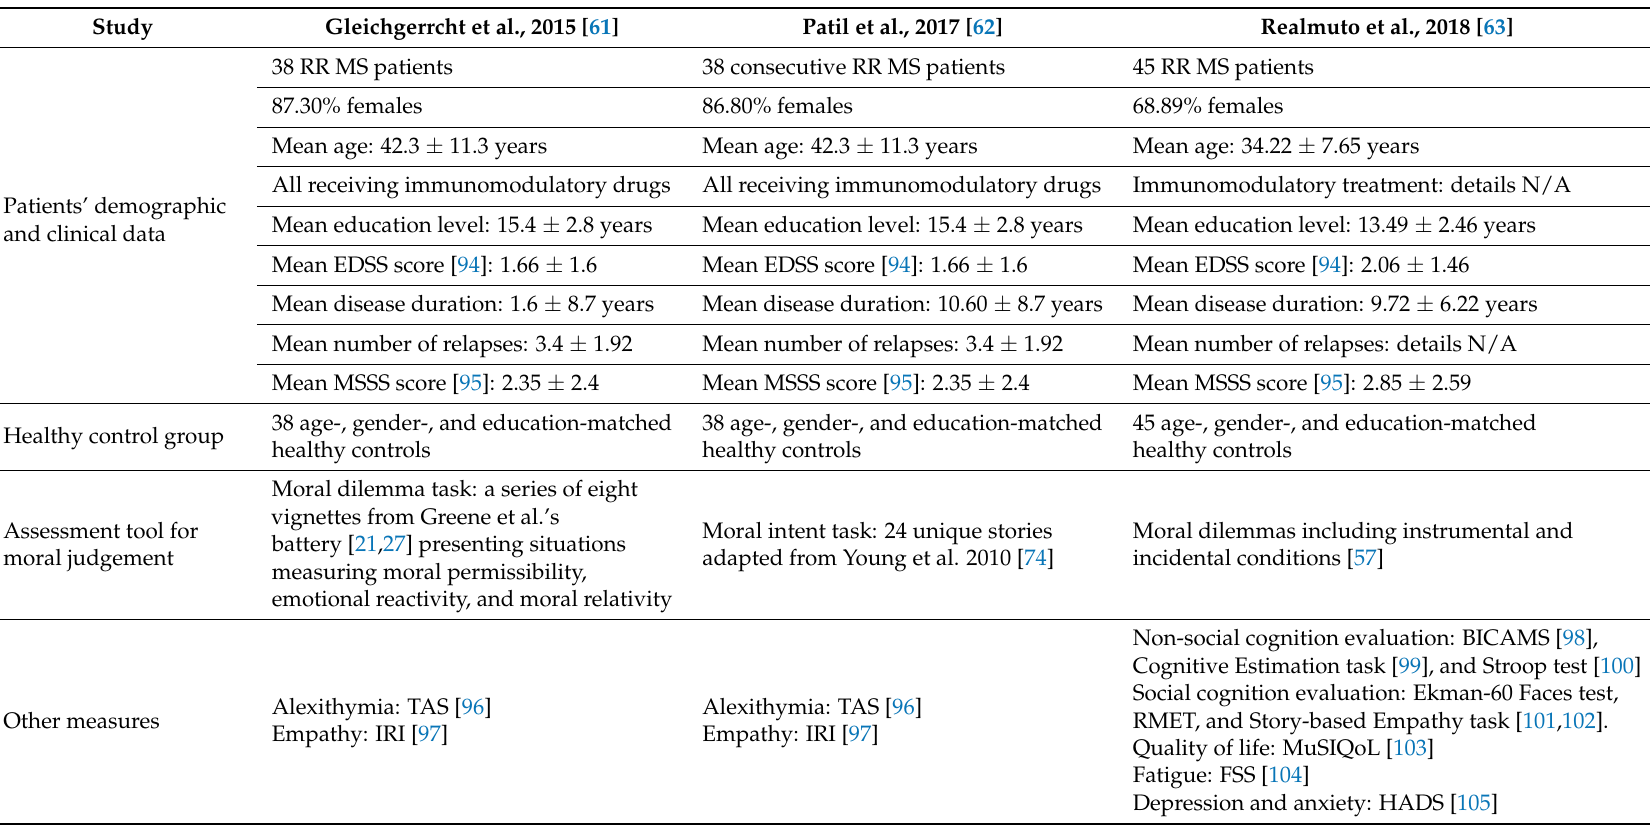
Table 1. A summary of studies assessing moral cognition in patients with multiple sclerosis